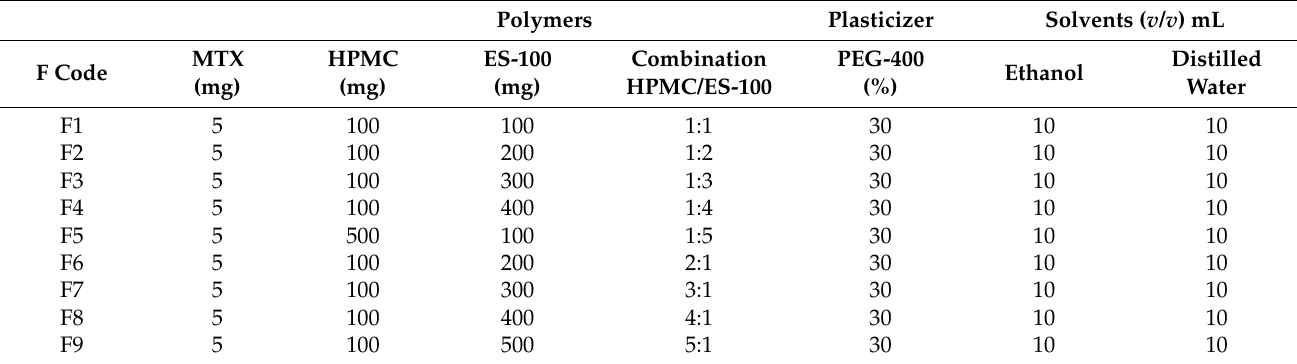
Table 1. Compositions of formulated transdermal